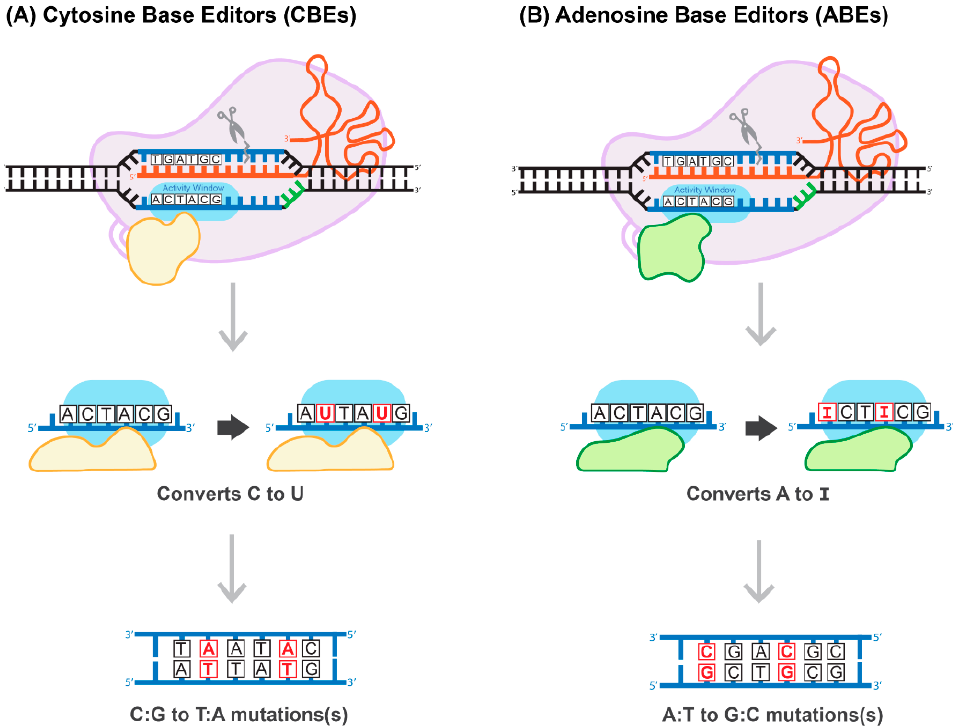
Figure 6. Proposed mechanism of base-pair editing CRISPR/Cas technology. ( A ) Cytosine Base Editors (CBEs) catalyze the conversion of all cytosines to uracils within a 5-6 activity window. Uracil is read as thymine during replication, which then converts all C:G to T:A. ( B ) Adenosine Base Editors (ABEs) catalyze the conversion of all adenosines to inosines within a 5-6 activity window. Inosine is read as guanine during replication, which then converts all A:T to